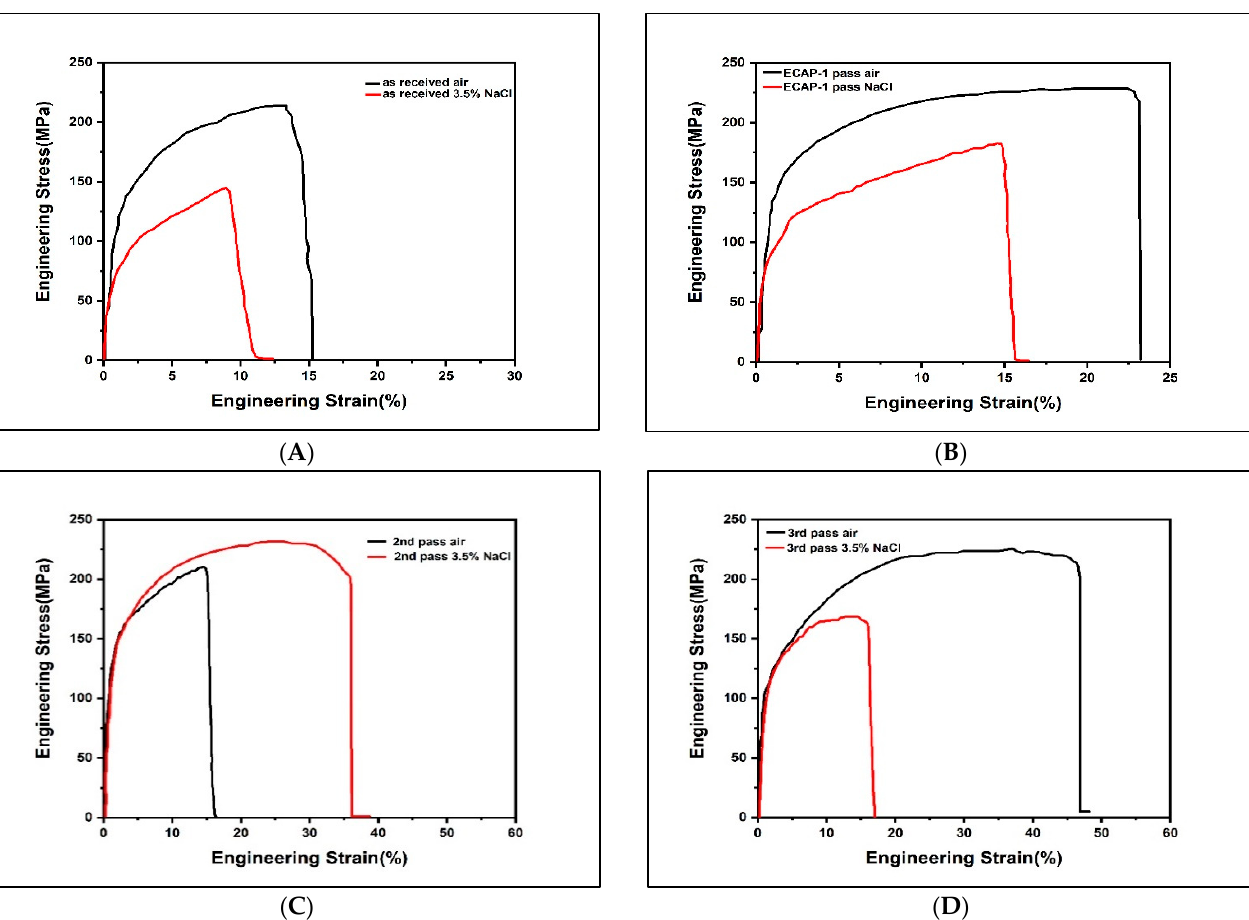
Figure 4. Stress–strain diagram of as-received Al5083 alloy ( A ) and ECAP after the 1st pass ( B ), 2nd pass ( C ), and 3rd pass ( D ) in air and 3.5% NaCl